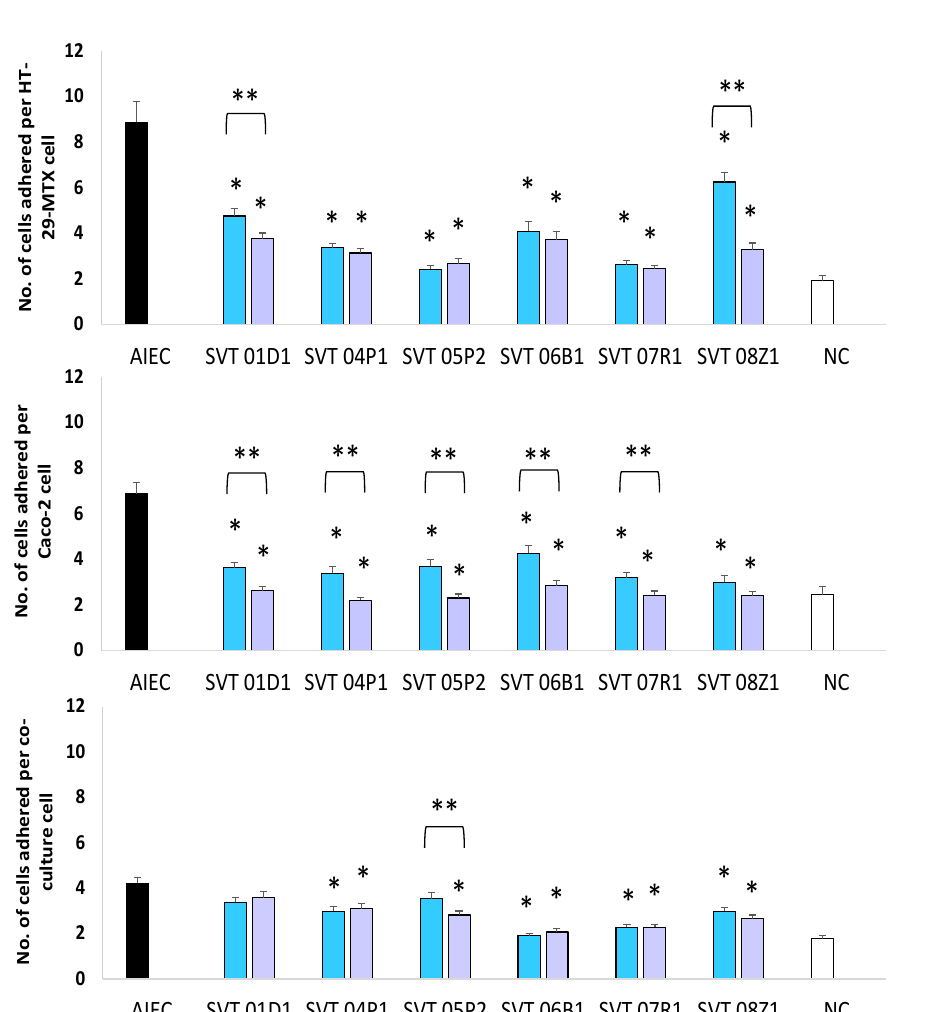
Figure 2. The number of AIEC cells adhering per cell on HT-29-MTX, Caco-2 and co-culture of Caco-2/HT-29-MTX cells. AIEC alone , AIEC when co-inoculated with the LBPs , AIEC when cells were pre-inoculated with LBPs and negative control [NC] . Significant differences (*) were observed before and after the addition of LBP strains (co-inoculation or pre-inoculation); p < 0.0001 (HT-29-MTX), p < 0.0001 (Caco-2), p < 0.0001 (Co-culture). ** Significant difference between co-inoculation and pre-inoculation for SVT 05P2 ( p = 0.049) and SVT 06B1 ( p = 0.04) in Caco-2, and SVT 08Z1 ( p < 0.0001) in HT-29-MTX.